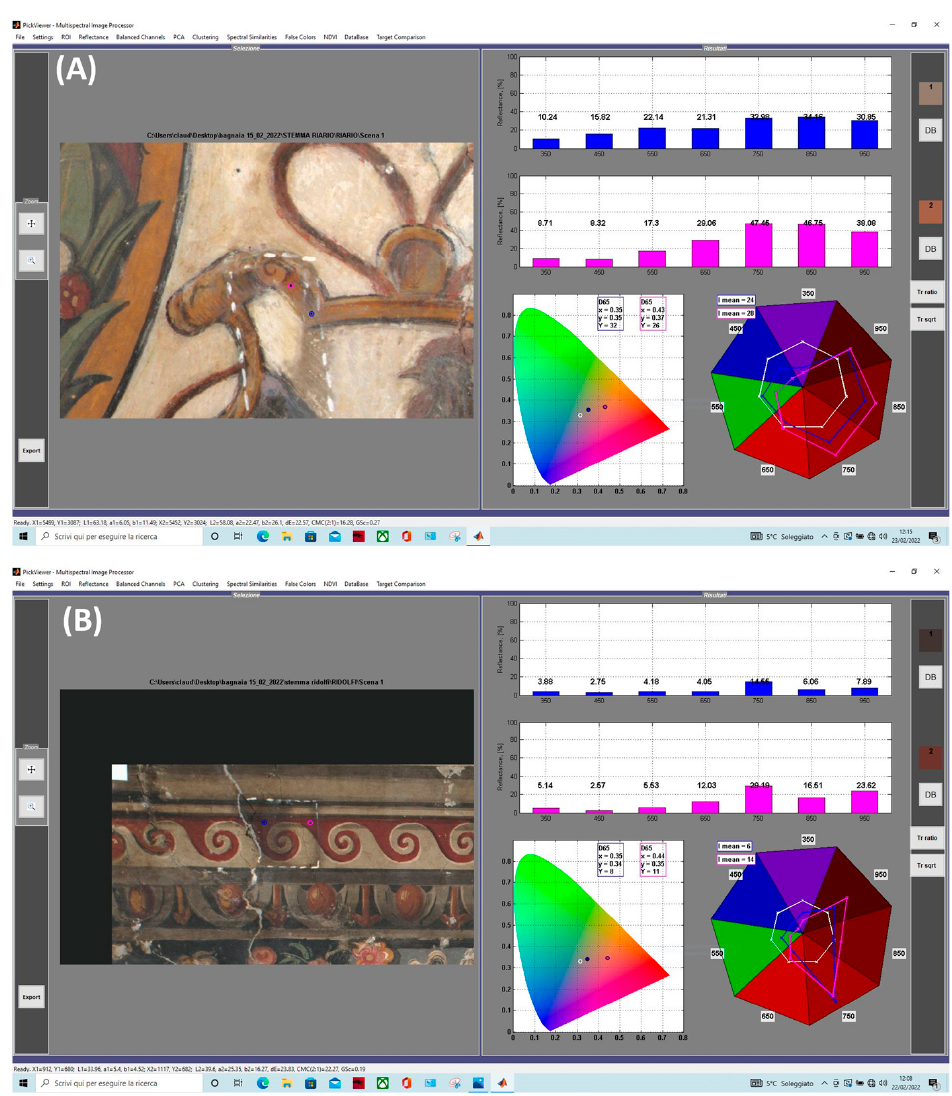
Figure 15. Chromatic and reflectance comparison between cleaned and uncleaned areas on the yellow color in the Riario coat of arms ( A ) and on the red color in the frieze ( B ) showing a clear increase in saturation due to the removal of the surface soot layer.